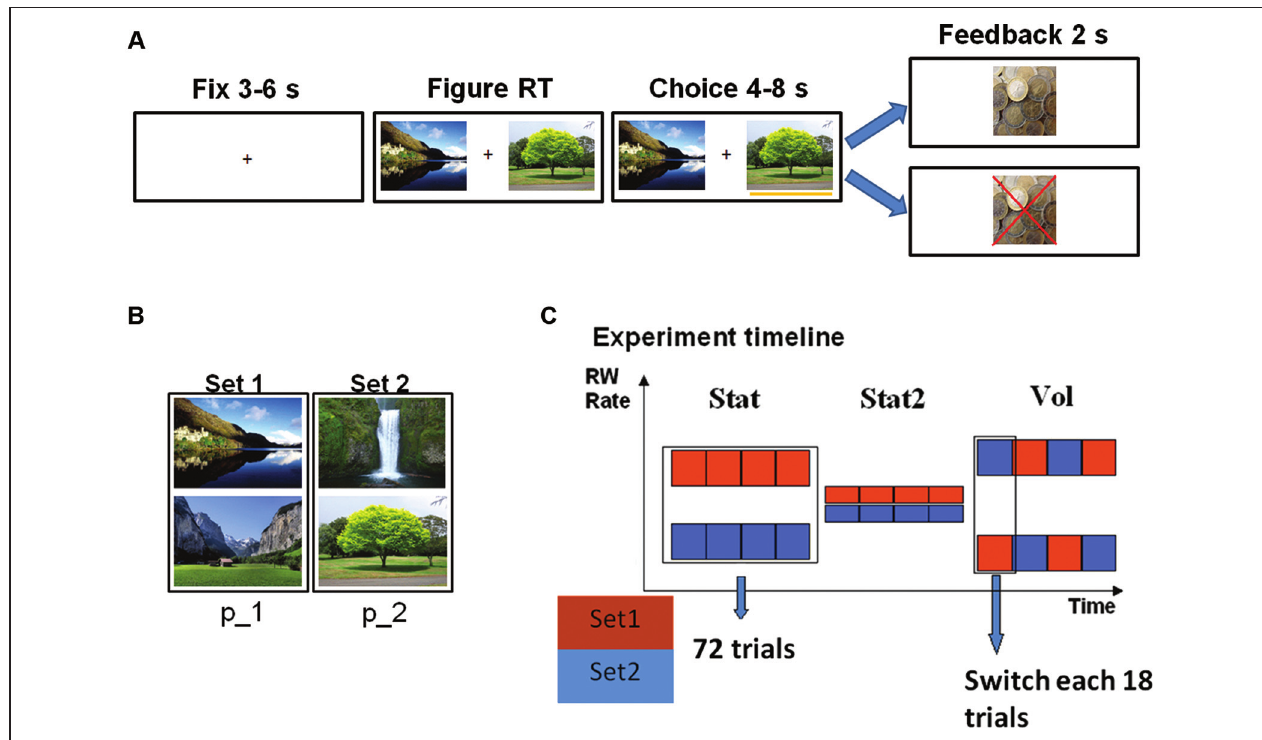
timeline showing reward rates for each figure set (color) as a function of time. Each square represents a block of 18 trials. During the volatile (Vol) environment, reward probabilities were switched between sets each 18